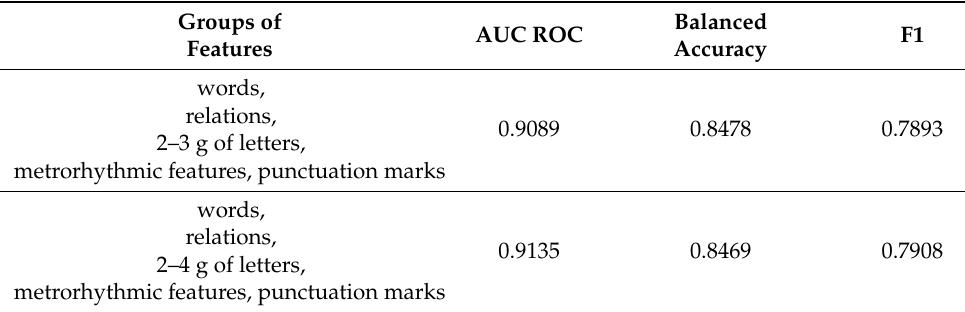
Table 10. The results of word classifications for the main data